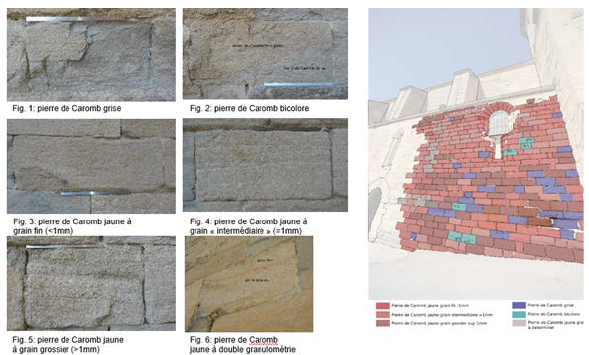
Figure 1. The classification of the stones according to the color and granulometry.